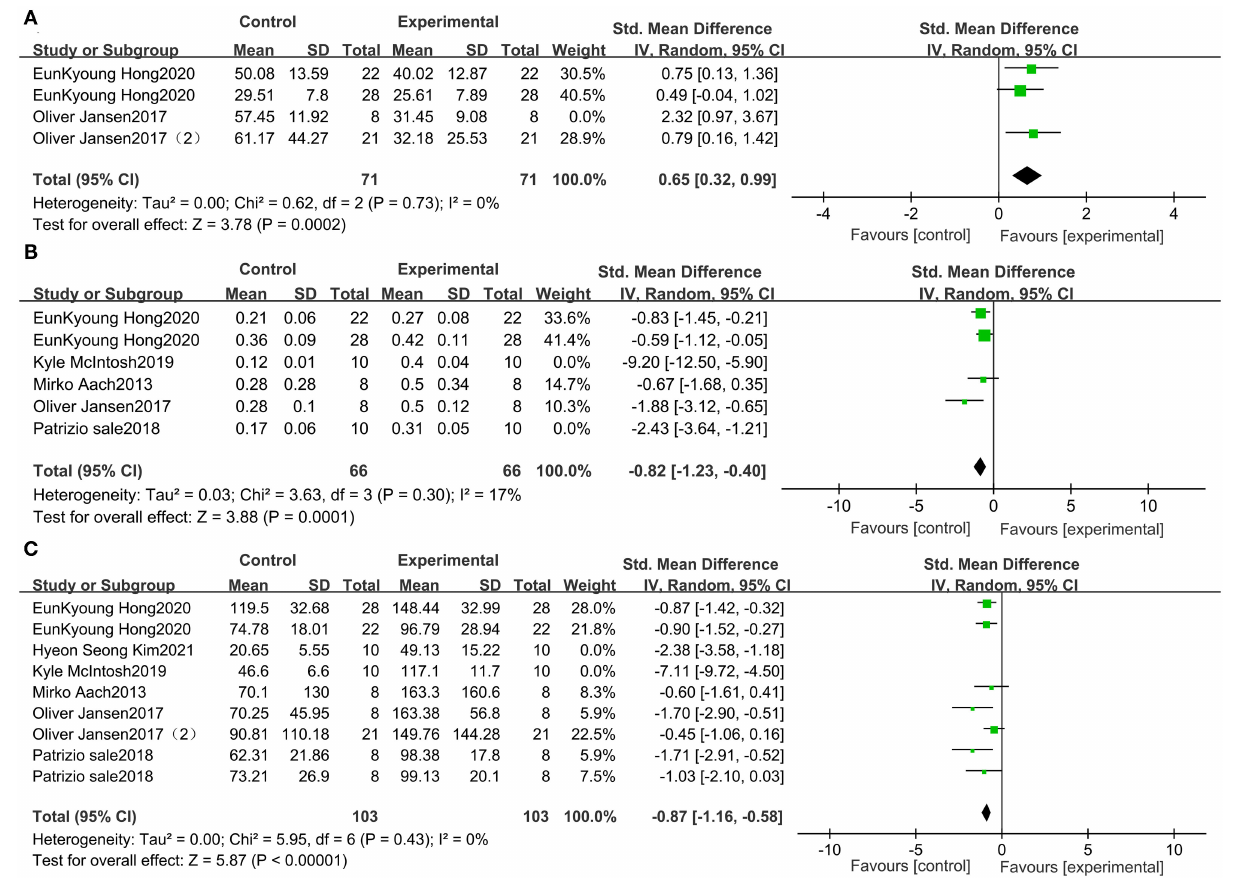
usability of exoskeletons for the clinical neurorehabilitation of patients with